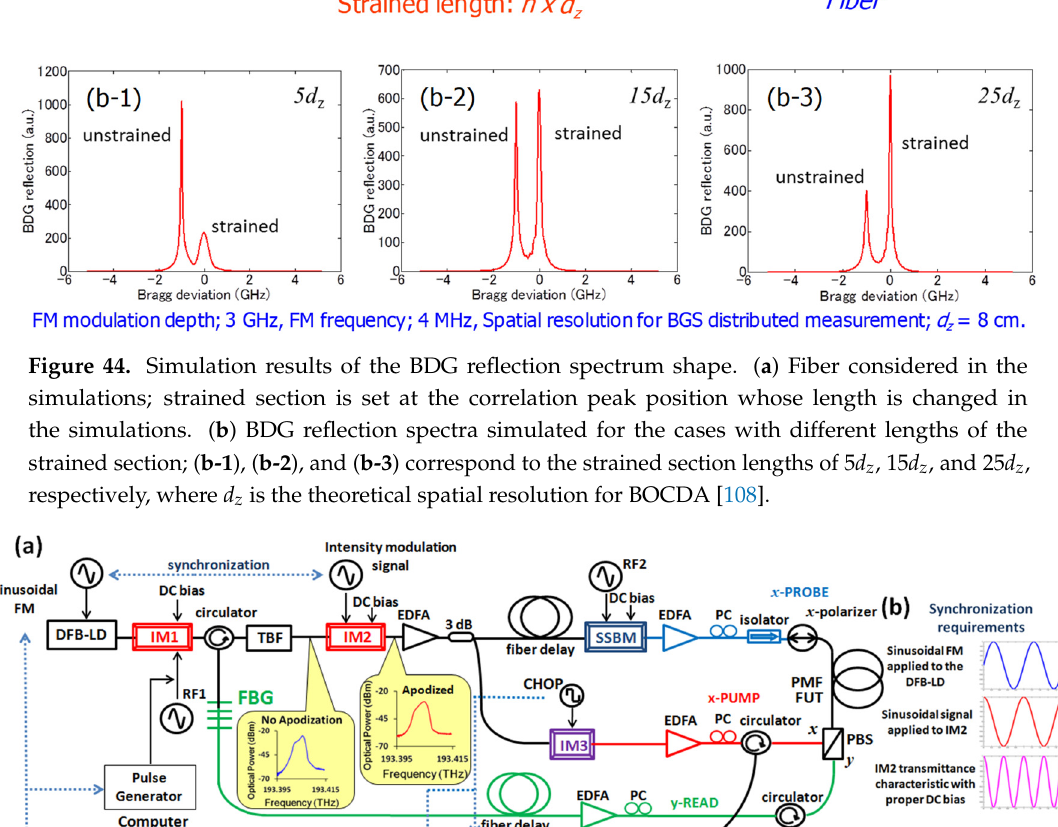
Figure 45. Experimental setup of the BDG-BOCDA system to confirm the spatial resolution improvement in the distributed measurement of the BDG reflection by the intensity modulation scheme